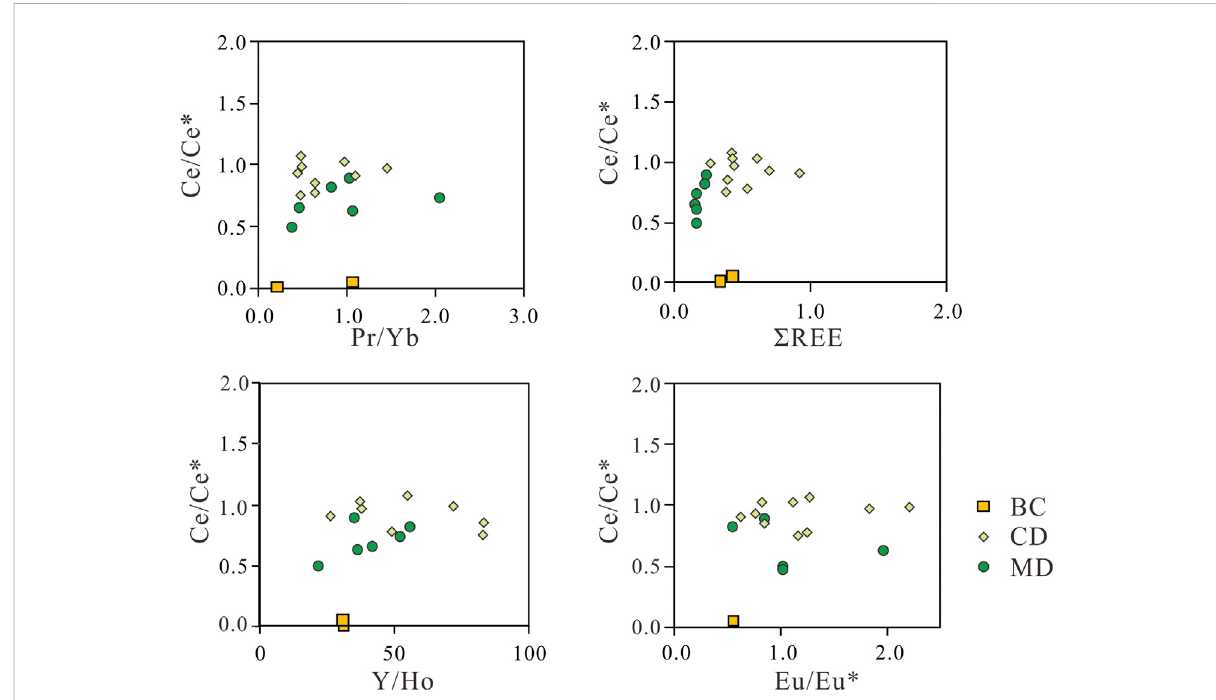
FIGURE 9 The cross-plots of rare Earth element parameters of different types of dolomites in the Xiaoerbulake Formation of the well XKD-1.